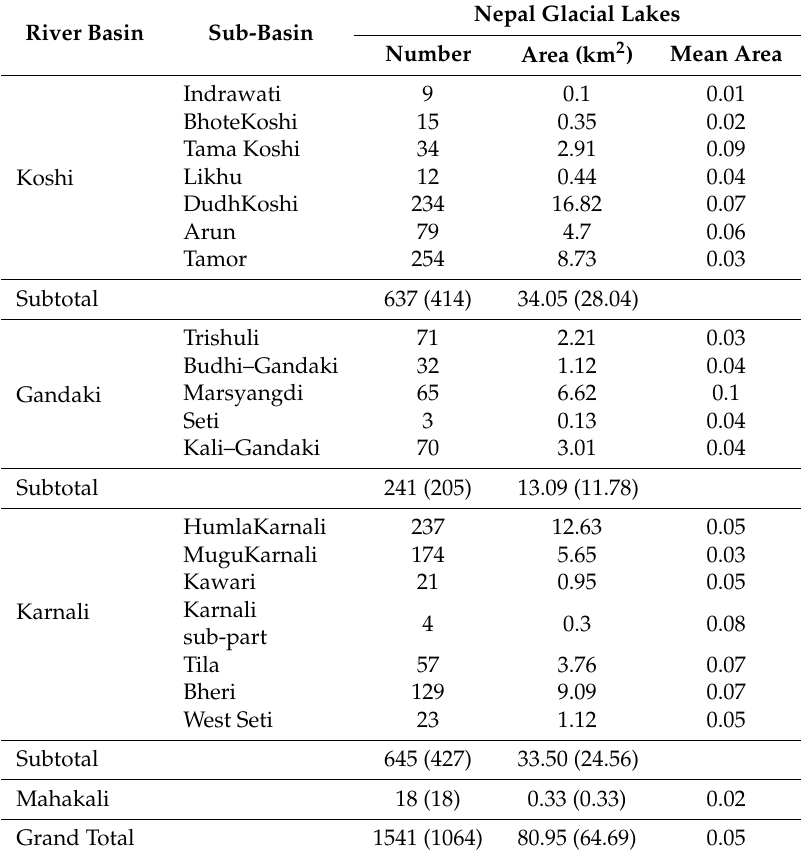
Table 2. Number and surface area (km 2 ) of glacial lakes in different sub-basins of Nepal in 2017. The values in parentheses indicate the number and surface area (km 2 ) of the glacial-fed lakes,